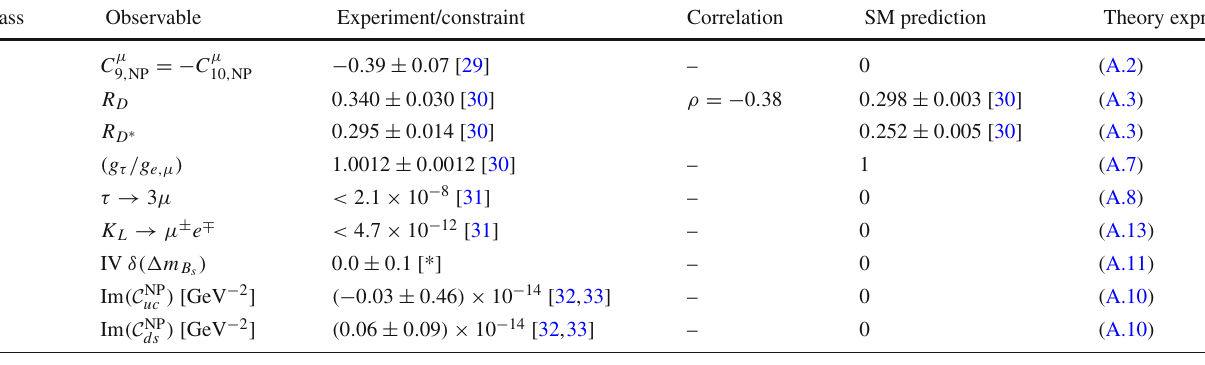
Table 2 Relevant low-energy observables. Upper bounds on branching ratios correspond to 90% CL. The entry marked with a [*] denotes our constraint imposed on the magnitude of (cid:4) m B . The only correlated measurements are those of R D and R ∗ , with correlation given by ρ D s Class Observable Experiment/constraint Correlation SM prediction Theory expr.